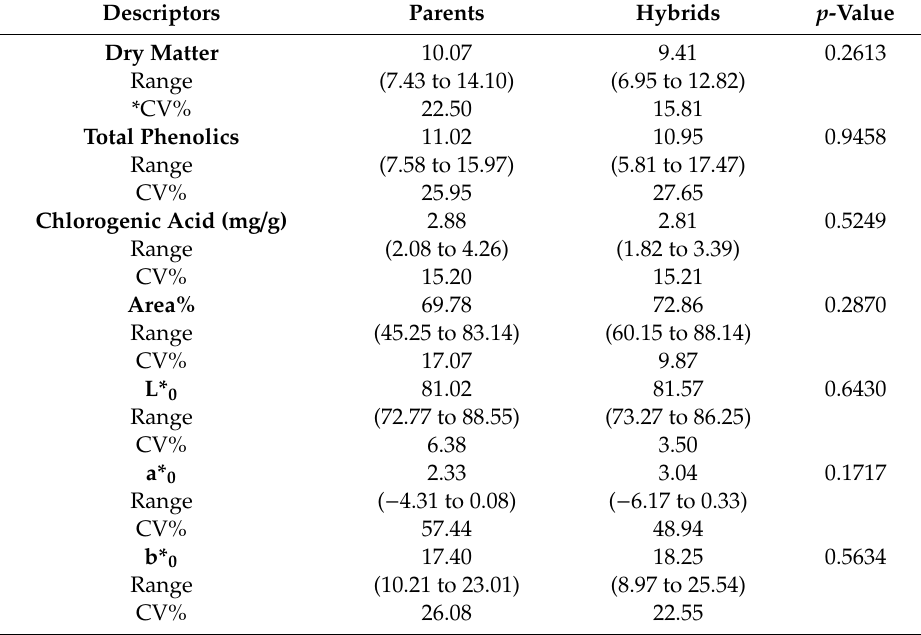
Table 1. Mean and range of variation for all the biochemical traits